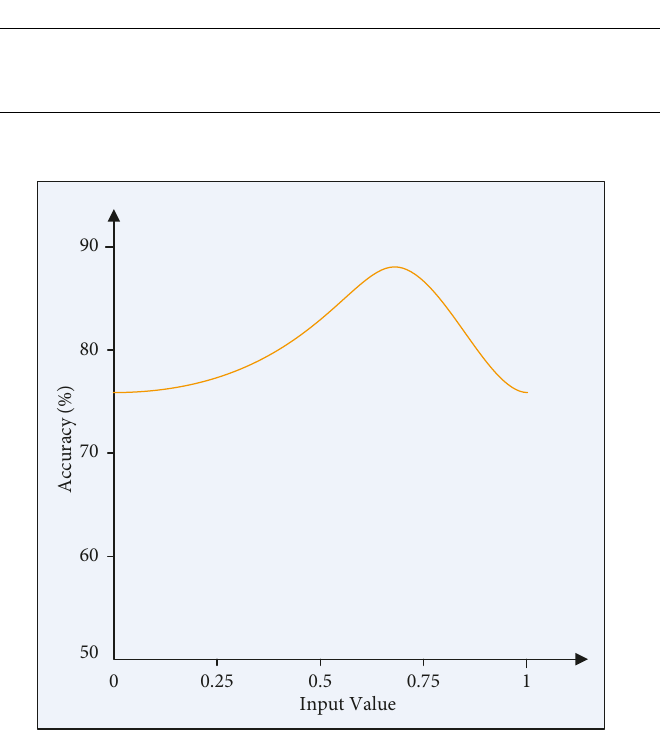
Figure 6: Line figure of weight value accuracy under different input values.